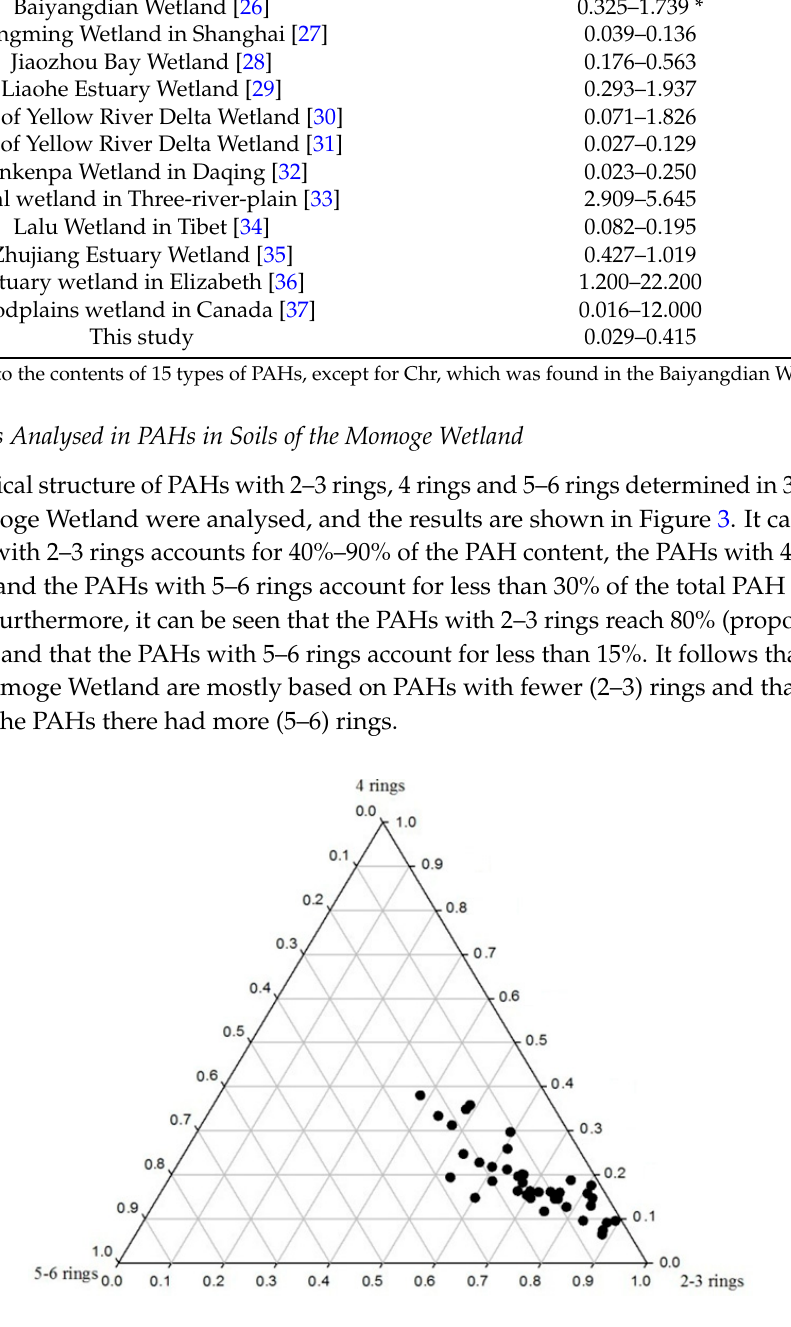
Figure 3. The contents of PAHs in soils of the Momoge Wetland.